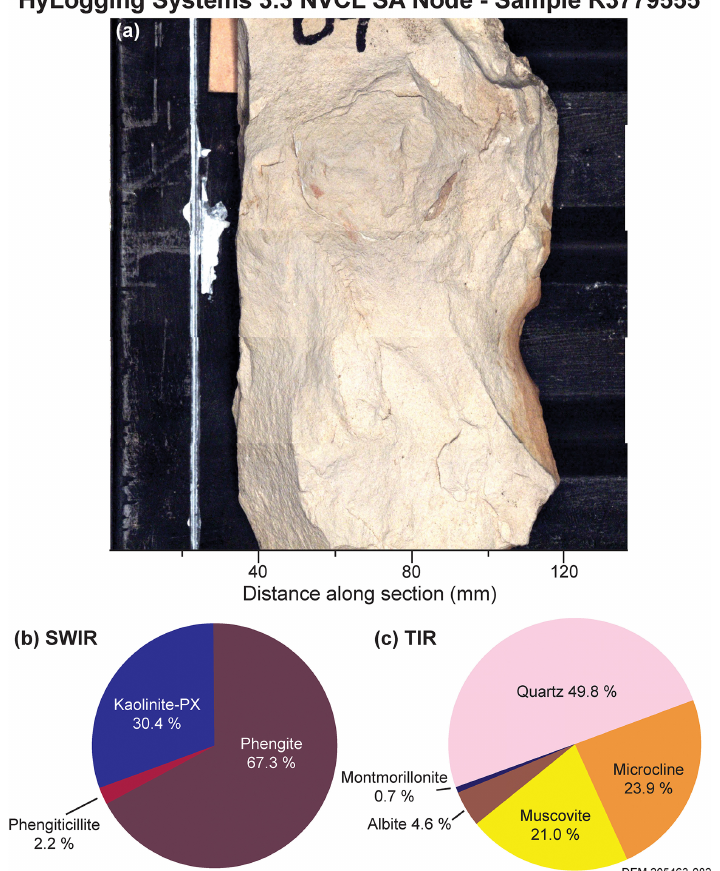
Figure A6. Hyperspectral mineralogy results for sample